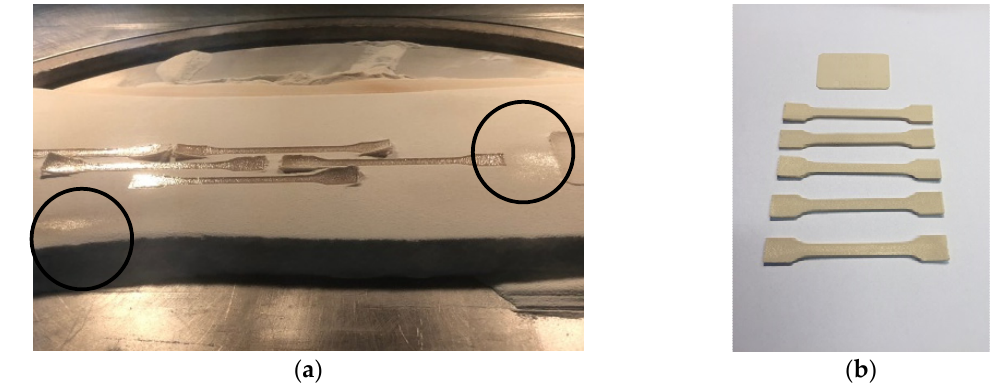
Figure 11. ( a ) Glossy hot spots (indicated by the circles) appearing on the powder bed where the temperature is too high; ( b ) Parts that could be built and tested. temperature is too high; ( b ) Parts that could be built and